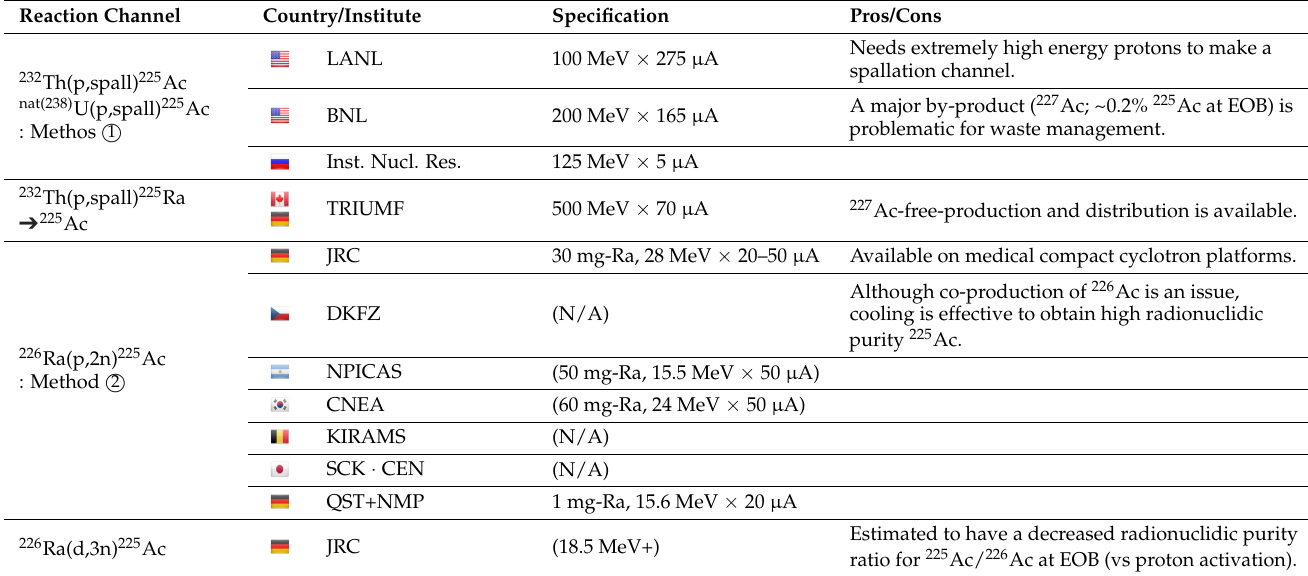
Table 1. Summary of projects investigating alternative 225 Ac production using accelerators.